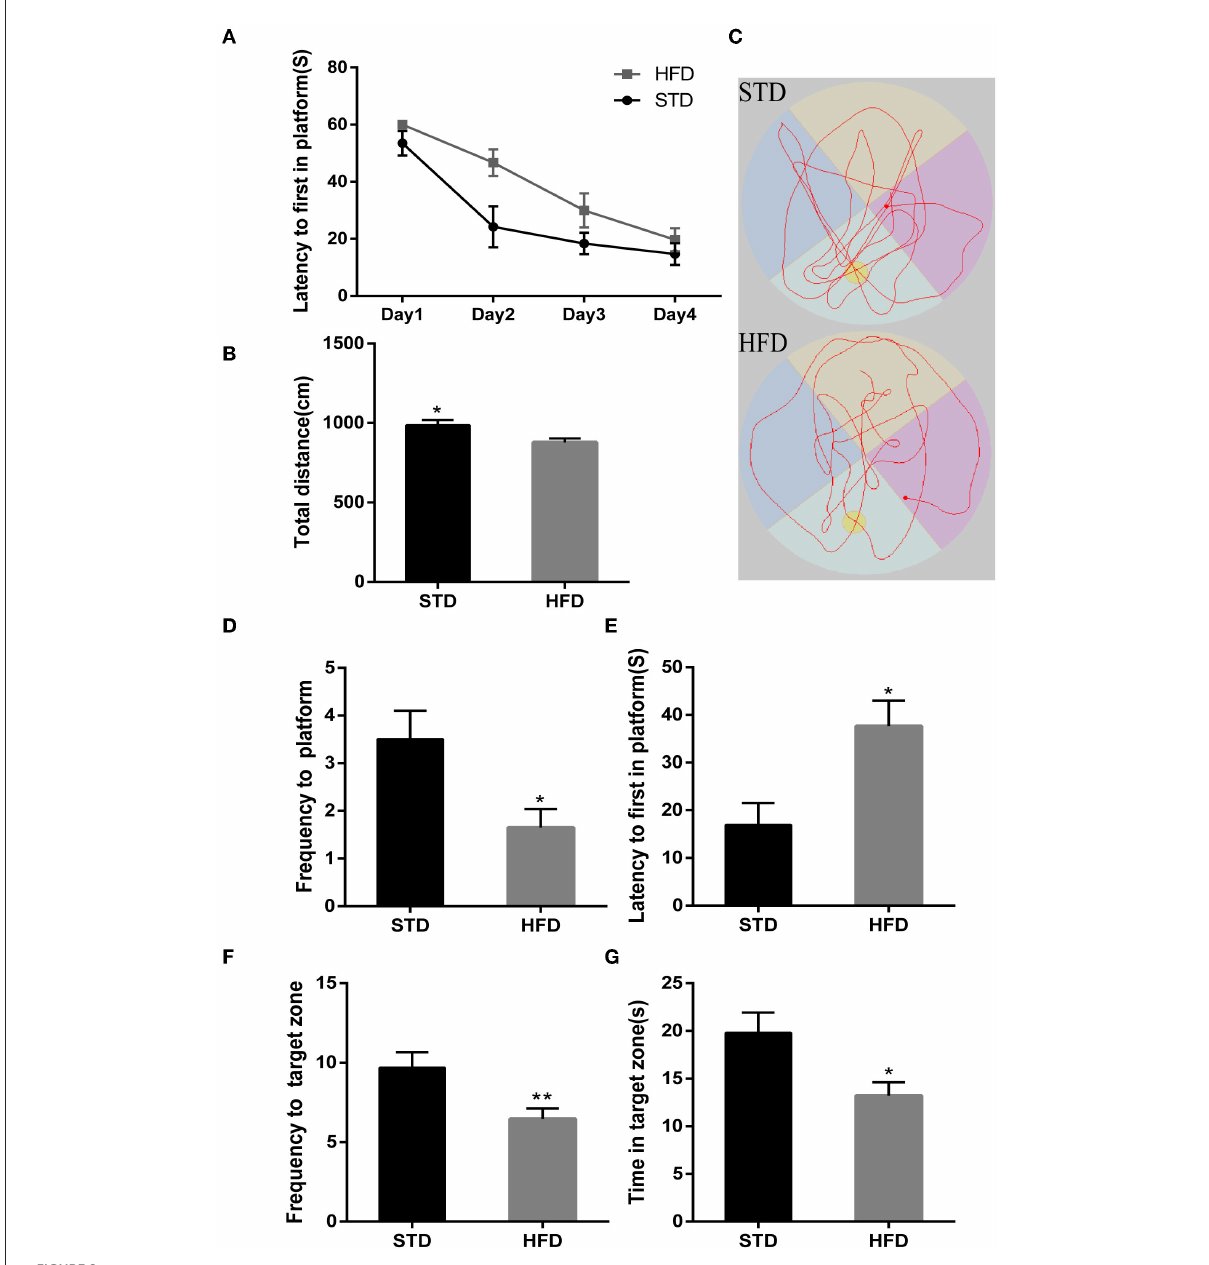
FIGURE2 The results in mice during Morris water maze test. (A) The place navigation test. (B) The total swimming distance of mice during the test. (C) Swimming trajectory of mice during 1min in the space probe test. (D) The frequency to a platform in the space probe test. (E) The escape latency of mice in the space probe test. (F) The frequency to the target zone where the platform is in during the test. (G) The target zone retention time during the test. * P < 0.05; ** P < 0.01. In the place navigation test, mice were trained from the 4th quadrant of the maze, and four replicate experiments were performed for each mouse, n = 12, 12. In the space probe test, a fixed direction was selected to perform the test independently three times for each mouse, and mean values were calculated for final analysis, n = 12,